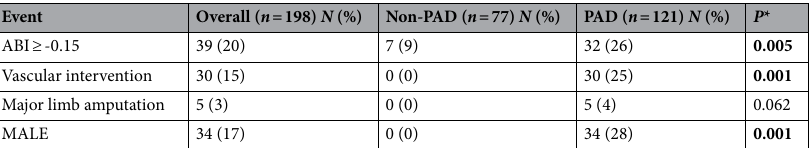
Demographics and clinical characteristics (at